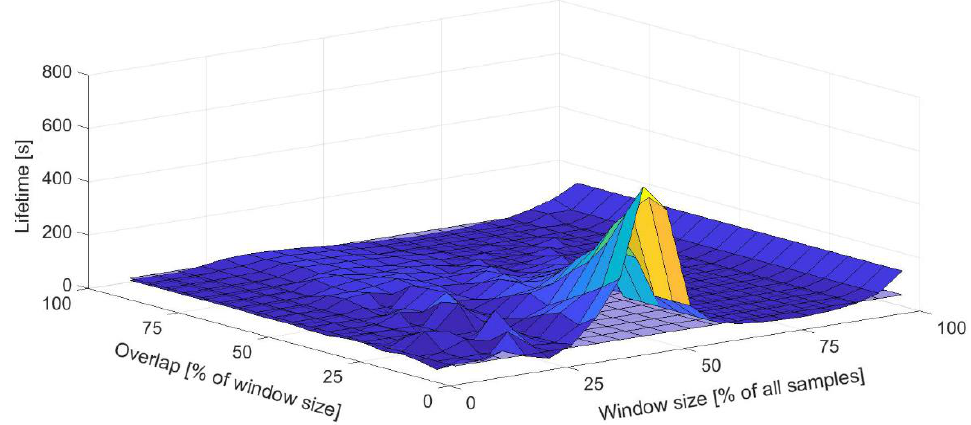
Figure 16. Matrix of lifetimes for different Welch’s parameters compared with the reference lifetime value.